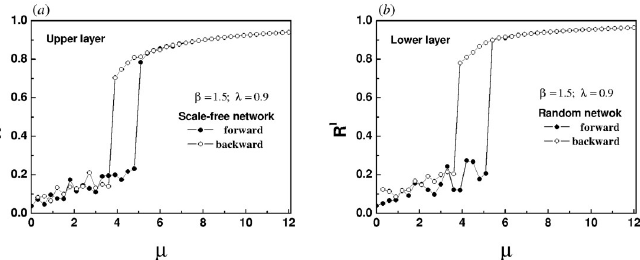
Fig 12. The panels show the evolution of order parameters of the upper (a) and lower (b) layers with the increase of intra-layer coupling strength for a bilayer network composed of a scale-free network in the upper layer and a random network in the lower layer. The inter-layer coupling strength λ is set to 0.9. The natural frequency of each oscillator in the upper layer is randomly selected in the interval [-1, 1], and the natural frequency of oscillators with the same label in the lower layer changes